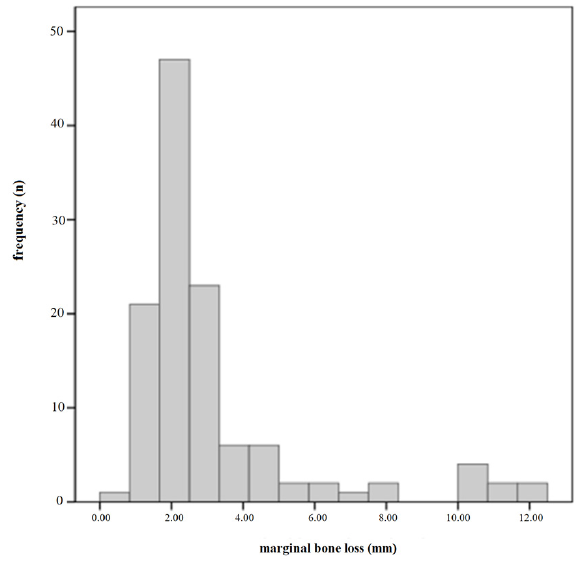
Figure 3. Distribution of marginal bone loss (MBL) at the implant level. The mean MBL (±standard deviation) was 3.15 ( ± 2.51) mm (95% confidence interval: 2.6962–3.6084), and the median value was 2.40 mm.